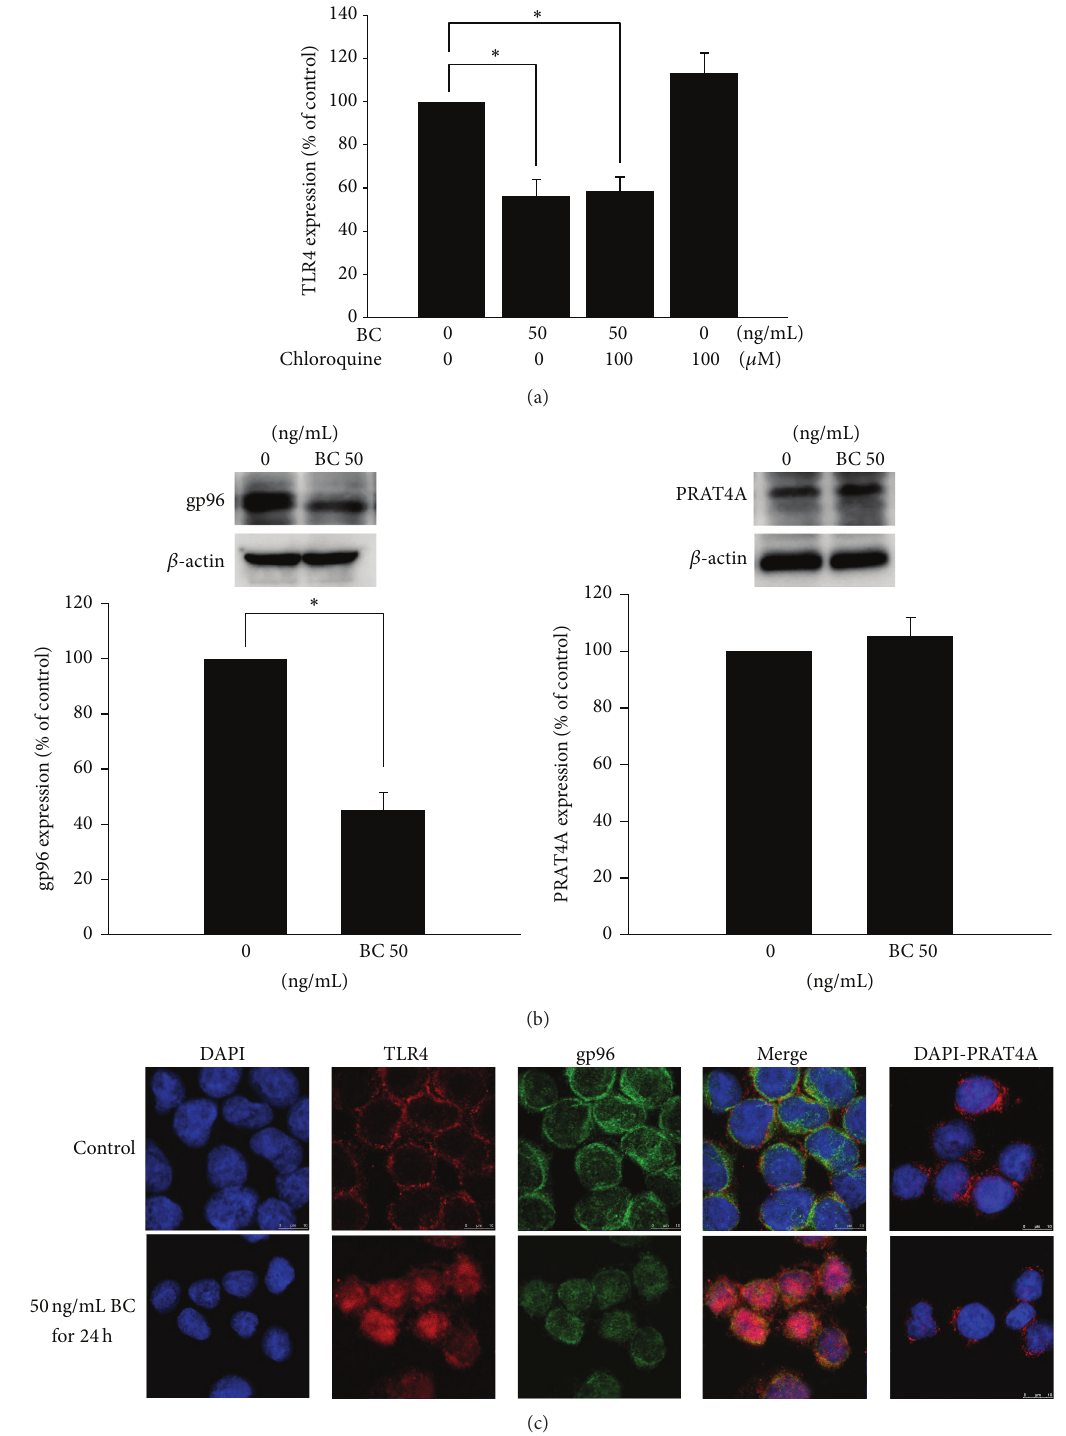
Figure 4: Involvement of glycoprotein 96 (gp96) but not protein associated with toll-like receptor 4 (PRAT4A) in the downregulation of TLR4 surface expression in U937 cells after bone component (BC) exposure. (a) U937 cells were pretreated with 100 𝜇 M chloroquine for 2 h before 50 ng/mL BC treatment for 24 h. Membranous portion of TLR4 in U937 cells was examined using flow cytometry, and results are presented as percentages of the control. Data are presented as mean ± SEM ( 𝑛 = 3 ); ∗ 𝑃 < 0.05 compared with the control group. (b) U937 cells were treated with 50 ng/mL BC for 24 h. Cellular gp96 and PRAT4A in U937 cells were detected using western blot analysis. 𝛽 -actin was used as an internal control. Data represent the results of 3 independent experiments (mean ± SEM; ∗ 𝑃 < 0.05 was considered significant). (c) U937 cells were stimulated with 50 ng/mL BC for 24 h. The gp96, PRAT4A, and TLR4 proteins were identified with specific antibodies by immunofluorescence. 4 󸀠 ,6-Diamidino-2-phenylindole was used to characterize the nucleus. The slides were observed by confocal